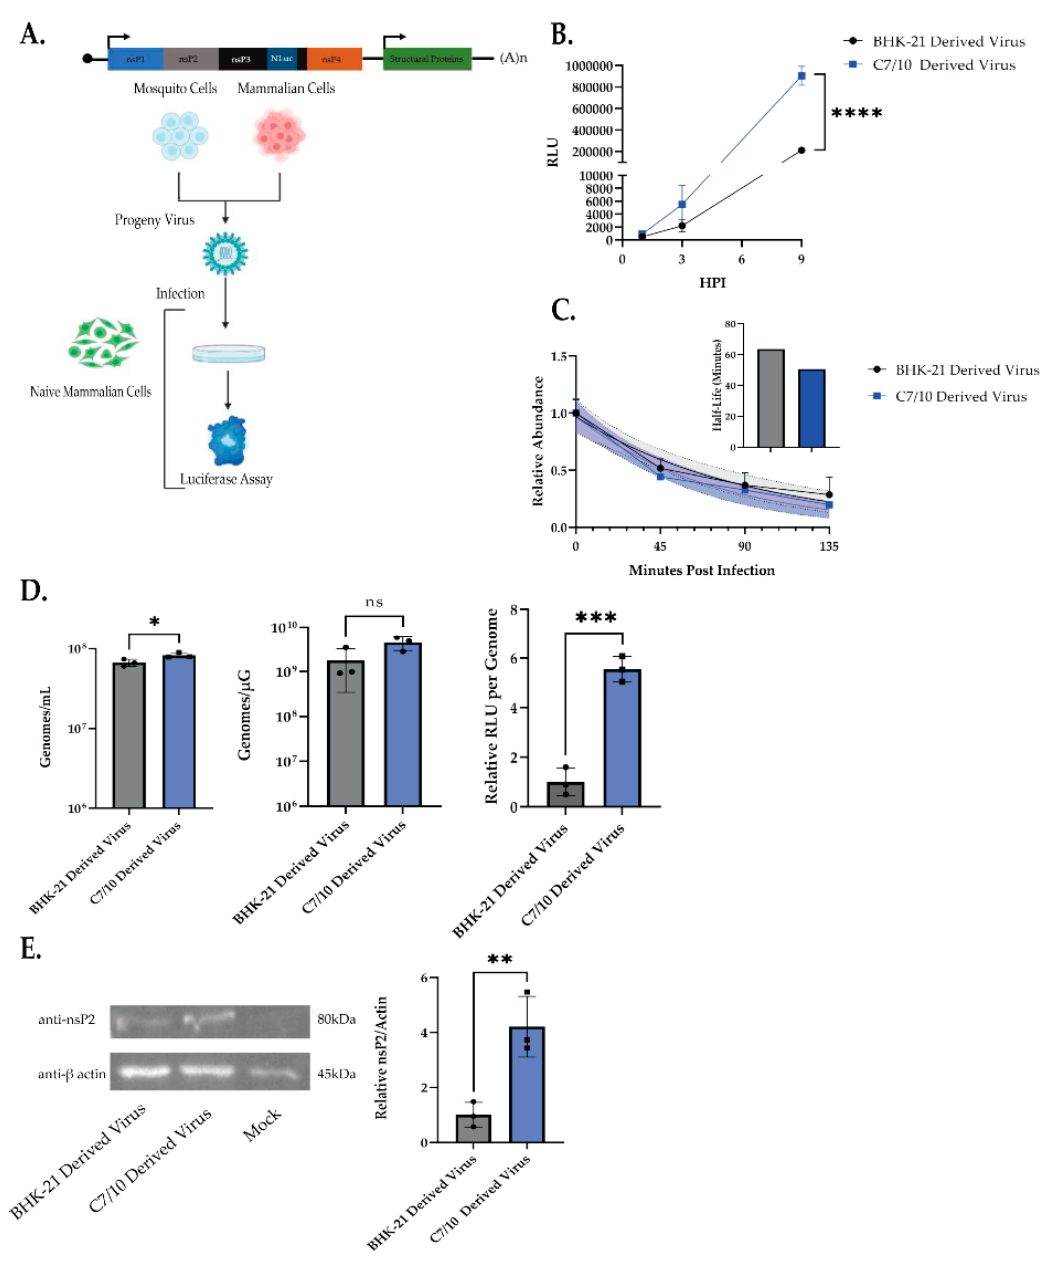
Figure 2. Mosquito-derived virus has increased translation compared to mammalian-derived virus. ( A ) Schematic representation of experiment performed. ( B ) Luciferase experiment performed in HEK-293 cells using Sindbis virus (SINV) carrying a translationally fused nanoluciferase (nLuc)